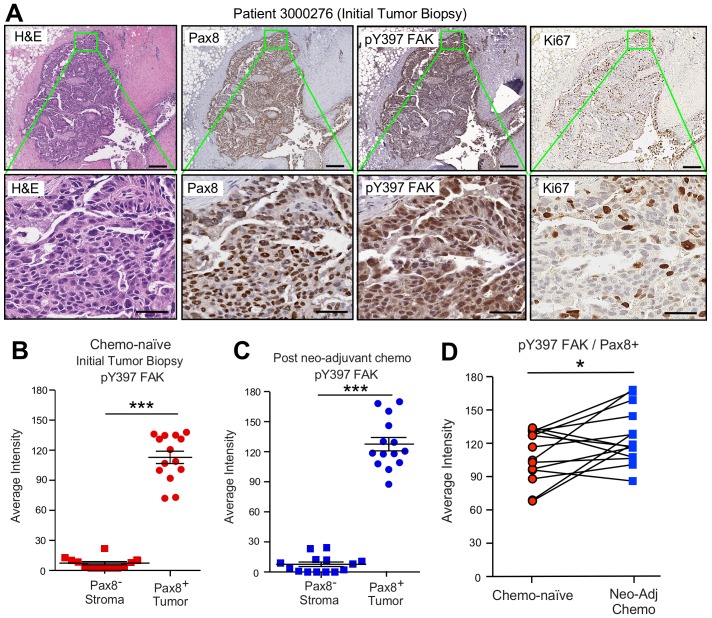
FAK Y397 phosphorylation (pY397) in HGSOC patient tumors surviving neoadjuvant chemotherapy.(A) IHC staining of paraffin-embedded serial initial tumor biopsy sections (patient 3000276) with H and E, Pax8, pY397 FAK, and Ki67. Scale is 200 µm. Inset (green box) region is shown at 40X (below). Scale is 60 µm. (B and C) FAK pY397 staining intensity of paired patient ovarian tumor samples from initial biopsies (panel B) and after surgical removal following neoadjuvant chemotherapy (panel C) within Pax8-positive (tumor) and Pax8-negative (stroma) regions. Dot plots are quantified staining from 14 paired patient samples (Aperio software) and bars show mean ± SEM (analyzed 11 regions per sample, ***p<0.001, unpaired T-test). (D) Increased FAK pY397 staining within Pax8-positive regions post-chemotherapy (*p<0.05, paired T-test). Lines are connecting paired patient tumor samples collected prior to and after neoadjuvant chemotherapy.